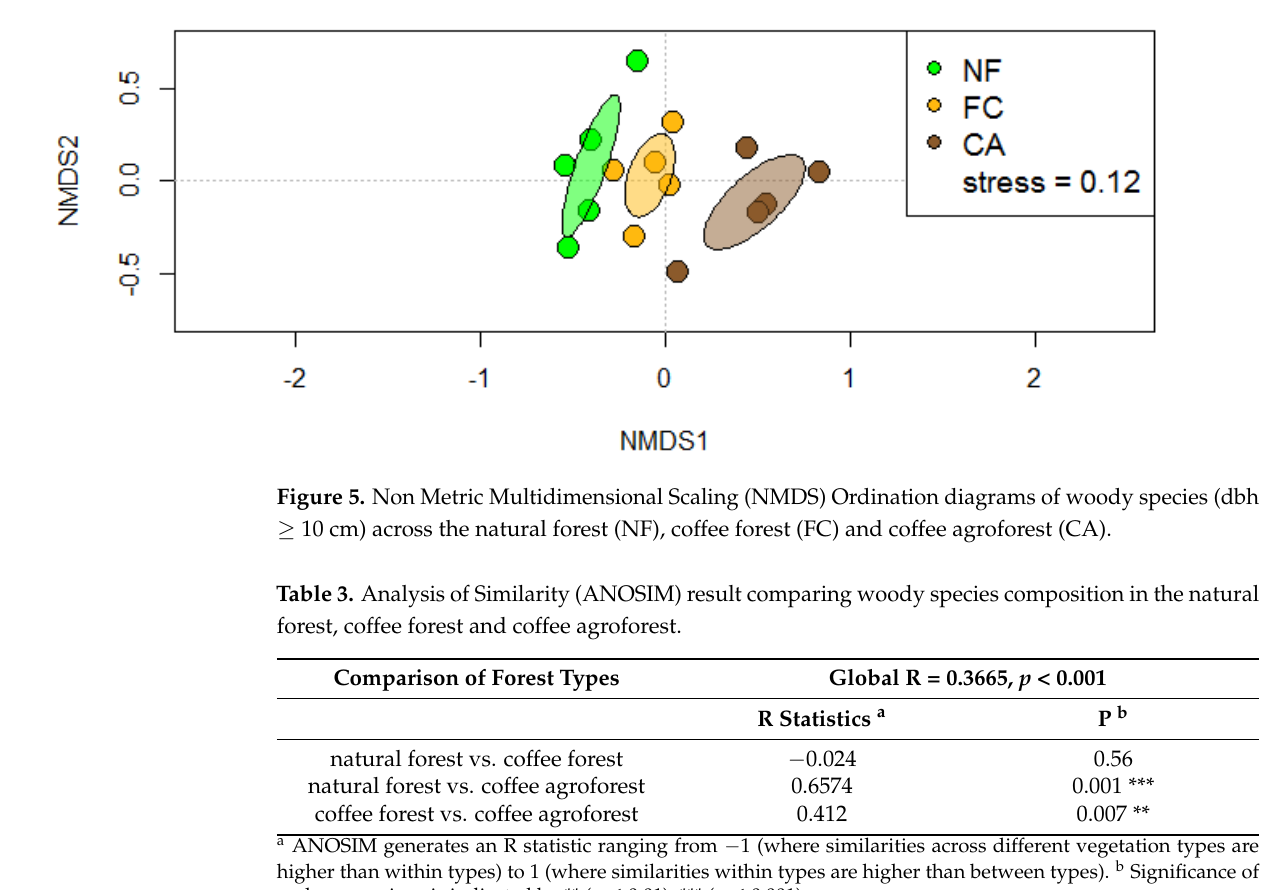
tree ( ≥ 30 m), medium tree (15 m to 30 m), small tree (0.5 m to 15 m), forest floor (<0.5 m). Natural